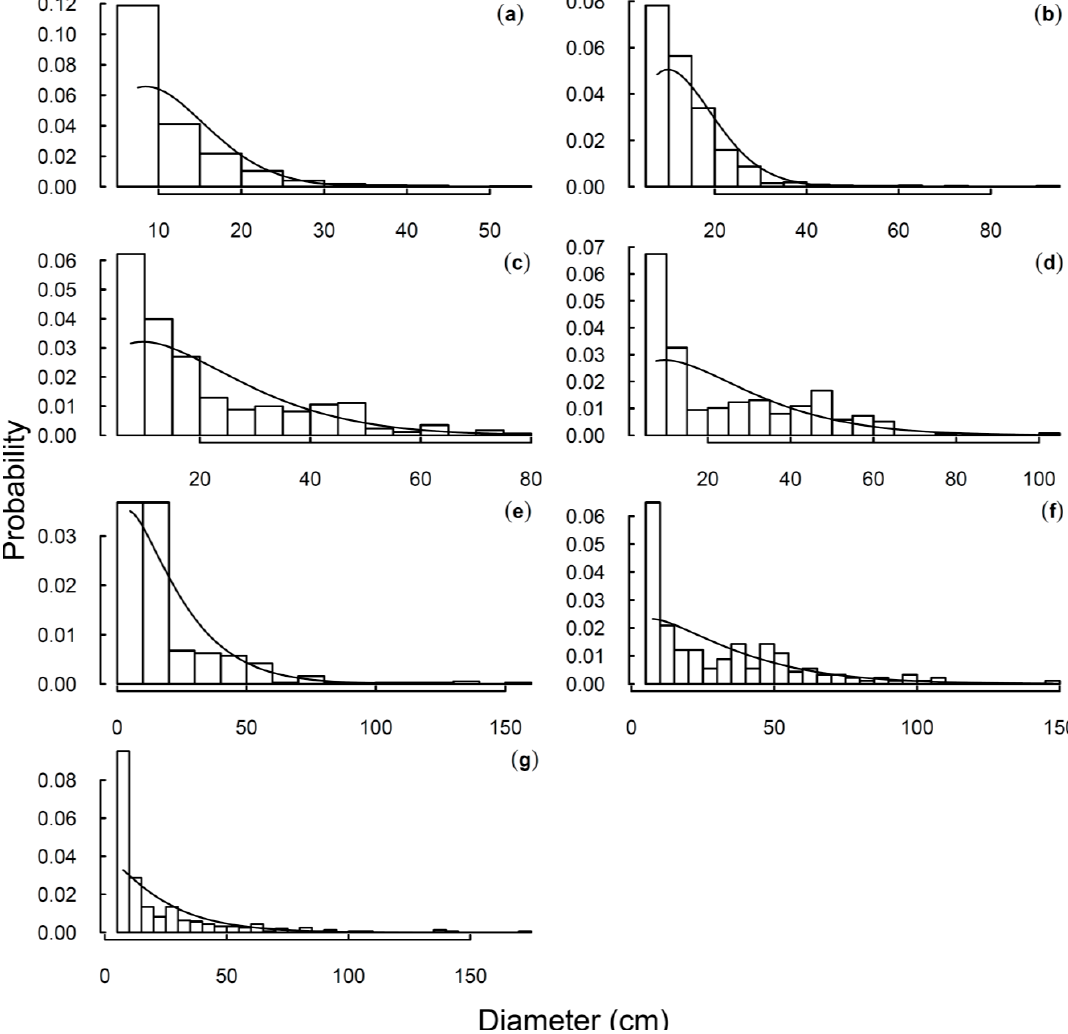
Figure A1. Diameter histograms and the fitted Weibull probability density function for live trees of